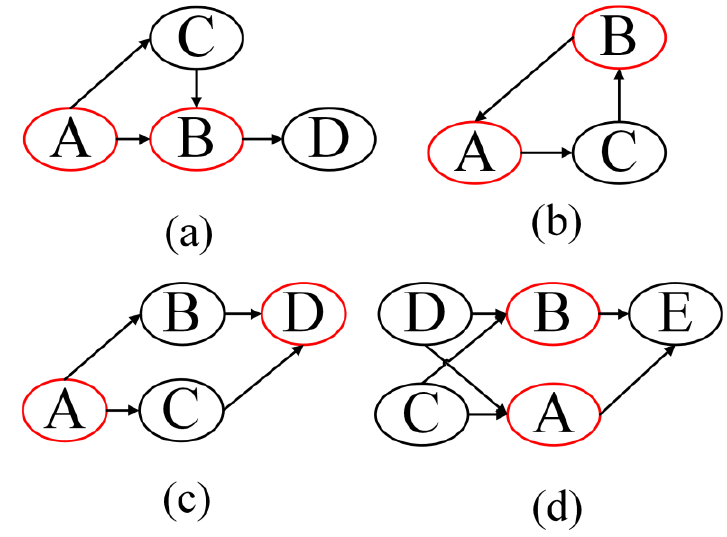
Figure 1. The four kinds of duplicate paths.